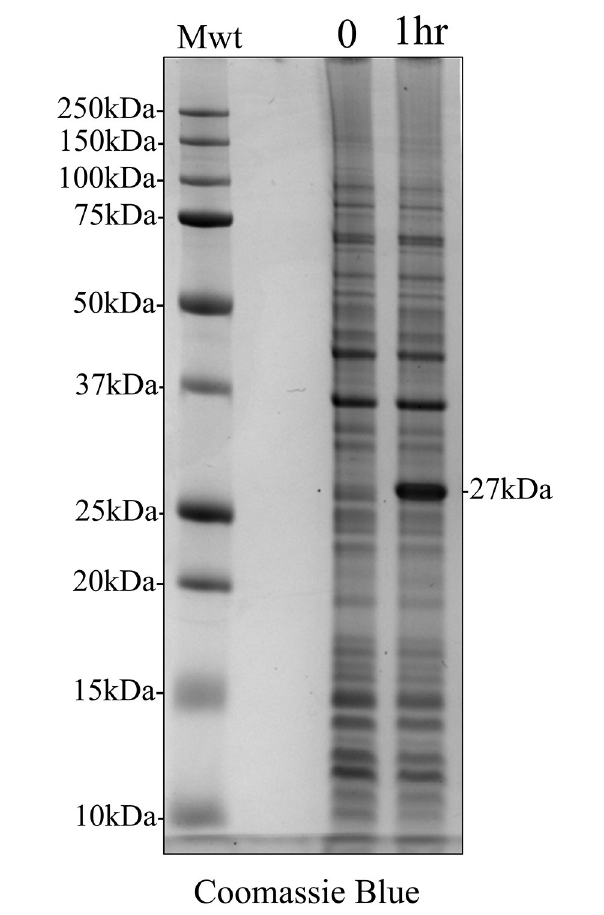
FIGURE 2 | Coomassie Blue stained analytical SDS PAGE showing IPTG induction of recombinant amelogenin expression in E. coli . E. coli were extracted at the time of induction (0) and 1 h post-induction (1 h). IPTG induced the expression of a 27 kDa protein corresponding to the expected molecular weight of recombinant amelogenin.